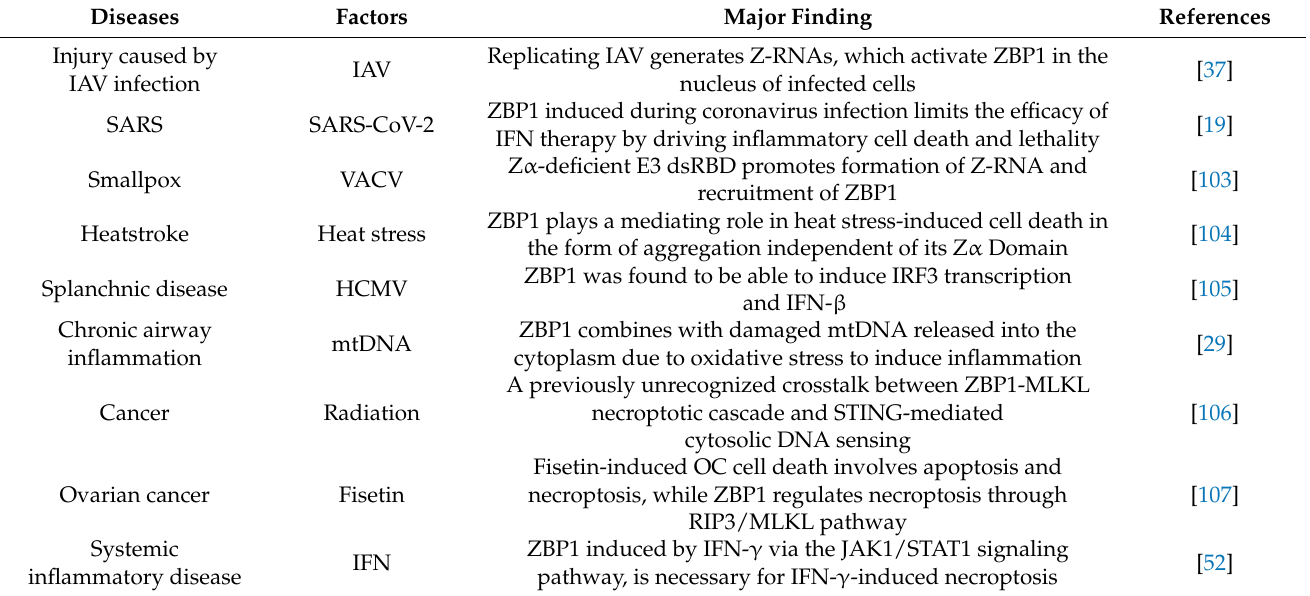
Table 1. ZBP1 mediates cell death and inflammation in different